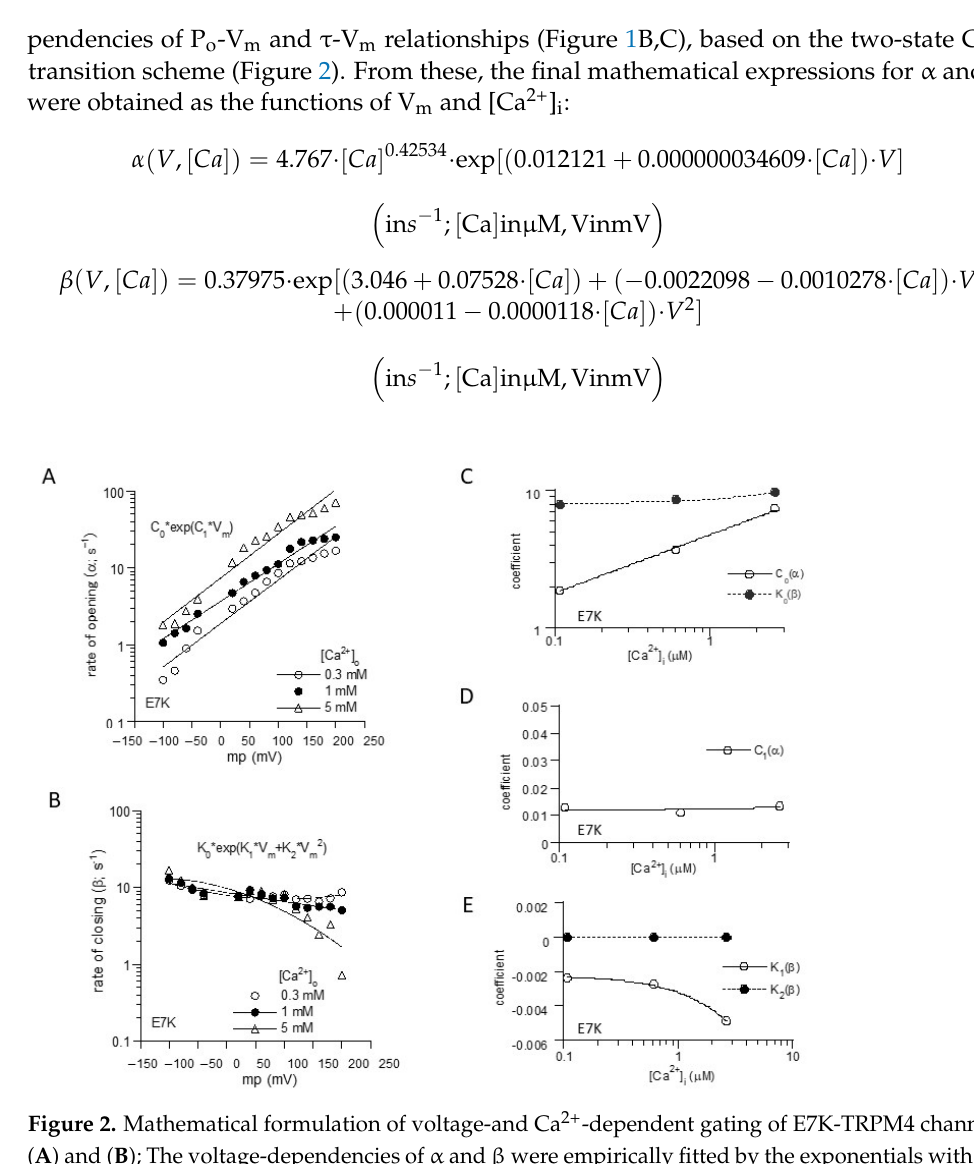
pendencies of P o -V m and τ -V m relationships (Figure 1B,C), based on the two-state C-O transition scheme (Figure 2). From these, the final mathematical expressions for α and β were obtained as the functions of V m and [Ca 2+ ] i :